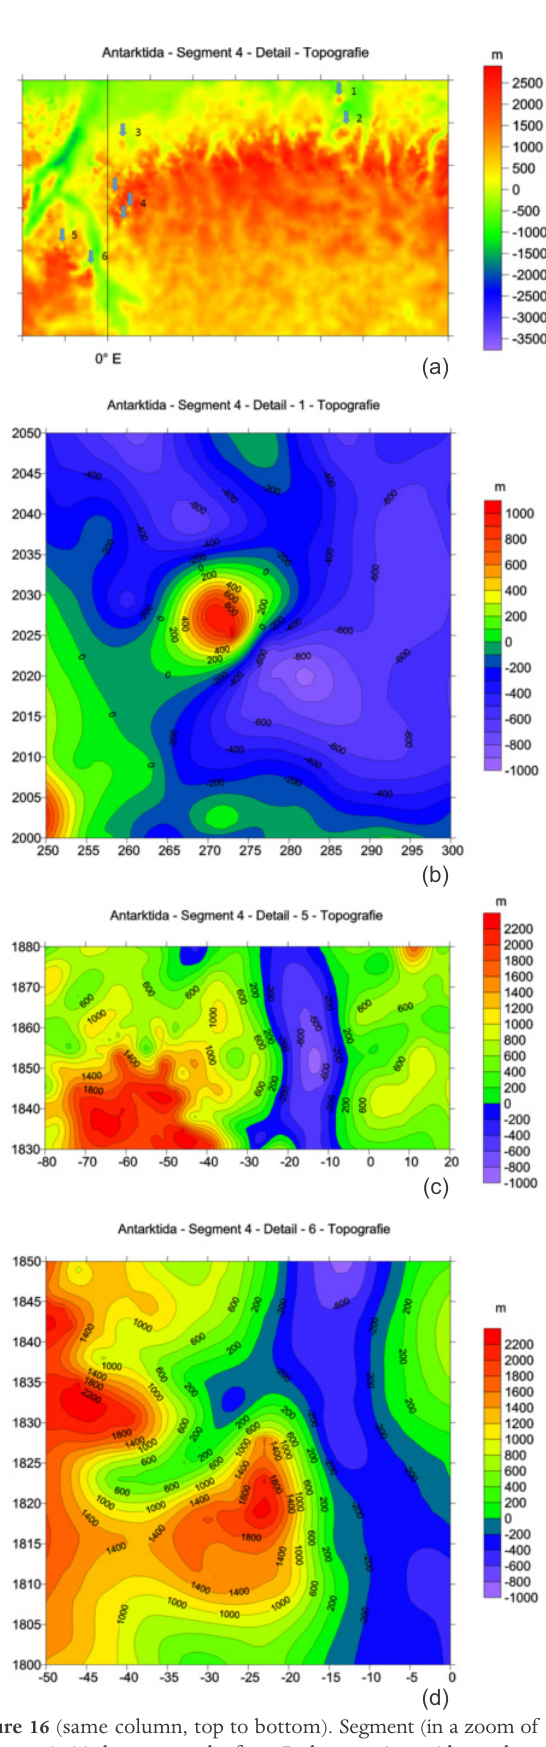
Figure 16 (same column, top to bottom). Segment (in a zoom of Figure 15a): (a) the topography from Bedmap2, view with numbers showing the positions of the following details (further and much more detailed zooms) for (b)-(d), 1, 5 and 6, all on land under the ice. The heights in (a) are in meters above sea level.